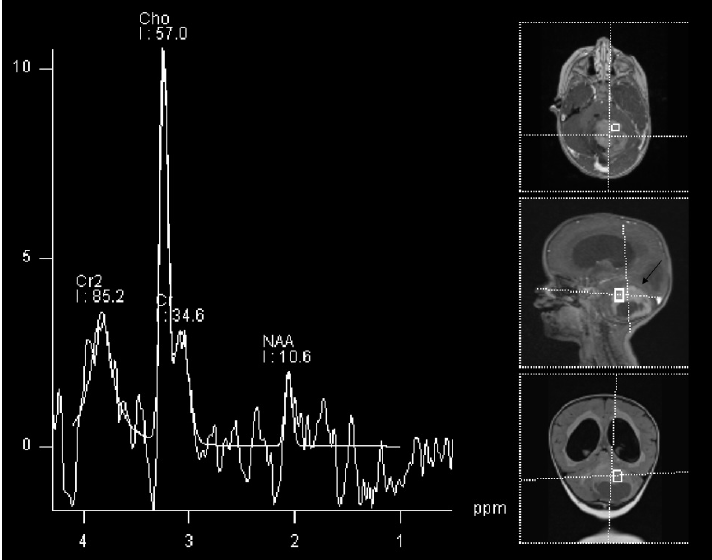
Figure 1. 1H-MRS in a patient (2 Y) with pilocitic astrocytoma (black arrow). Significantly increased Cho and decreased NAA and Cr are observed.